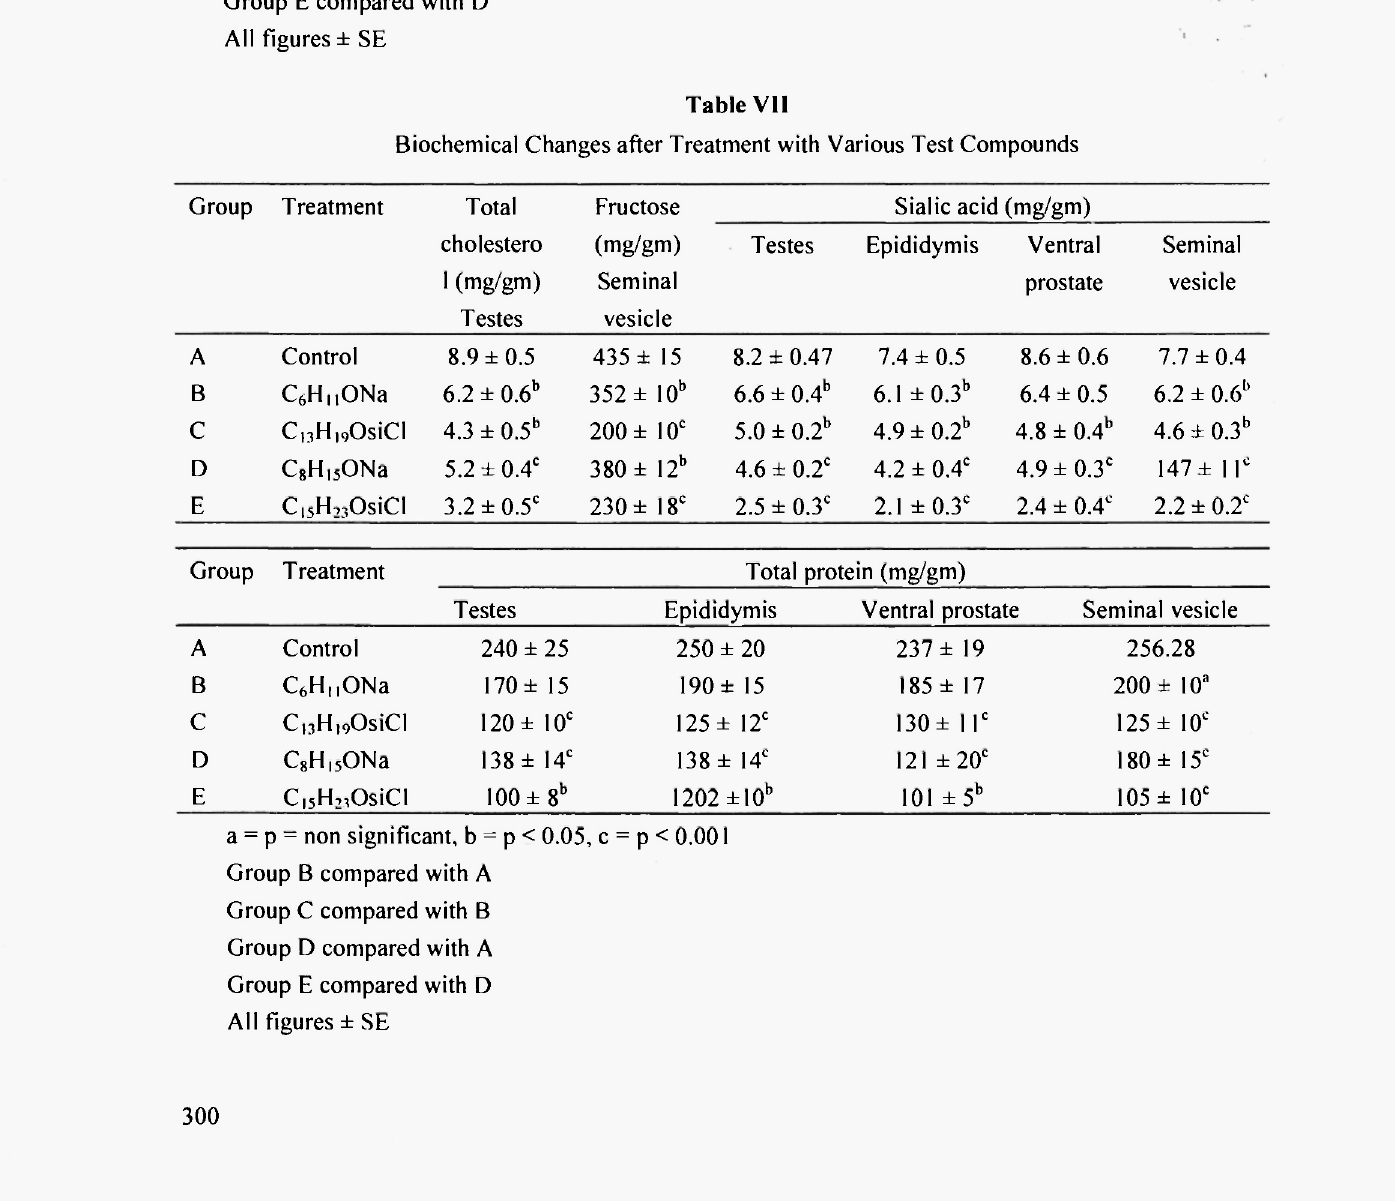
Altered Sperm Dynamics and Fertility after Treatment with Various Test